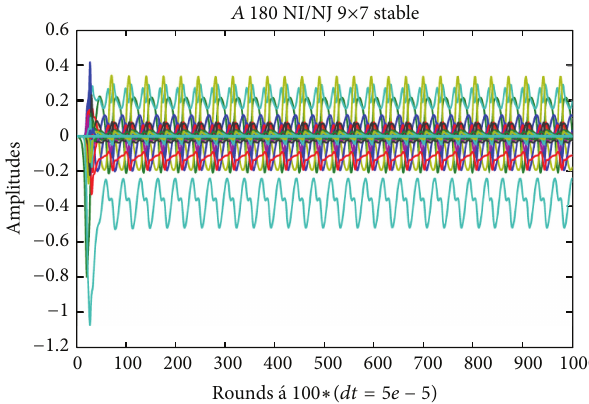
= 180 , stable, periodic motion to aL